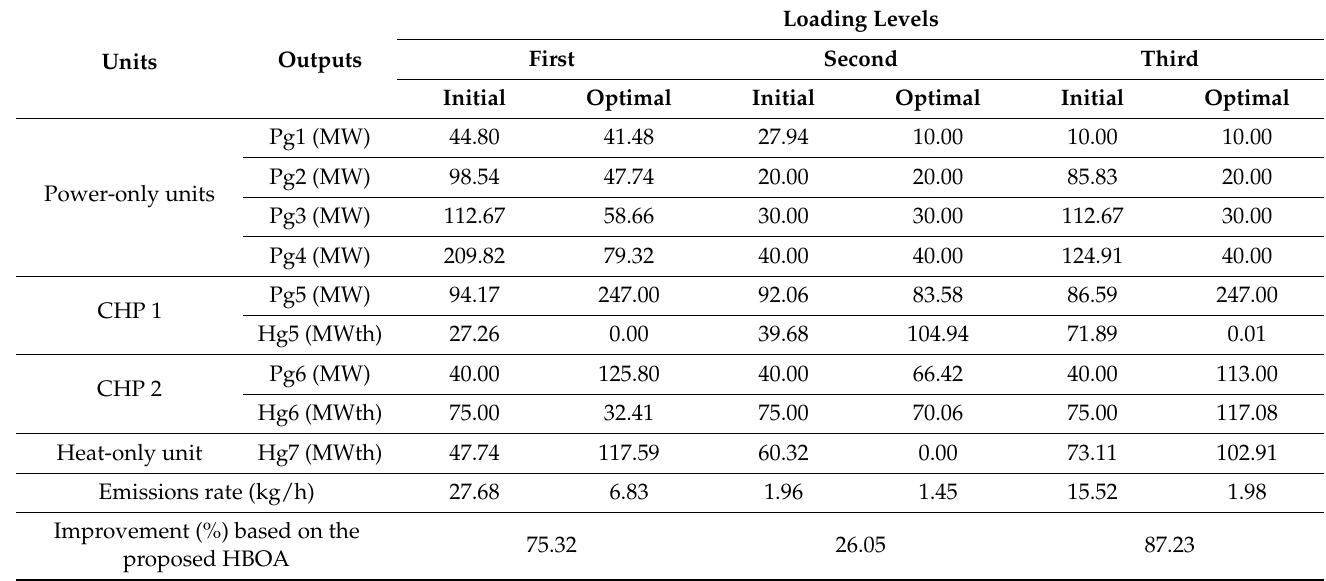
Table 8. Results of the proposed HBOA of Case 3 for the three loading